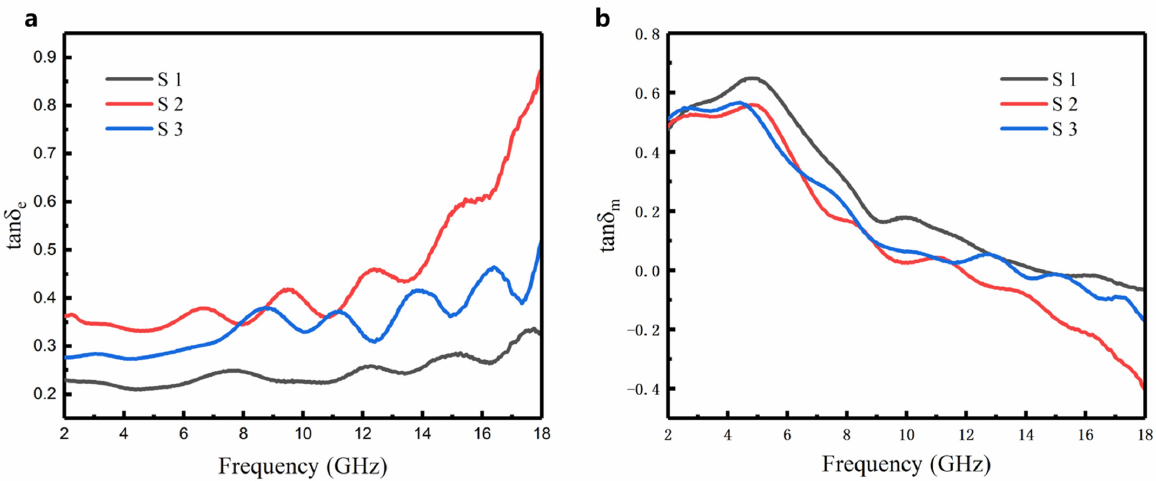
Figure 7. ( a ) the dielectric loss tan δ e , ( b ) the magnetic loss tan δ m .